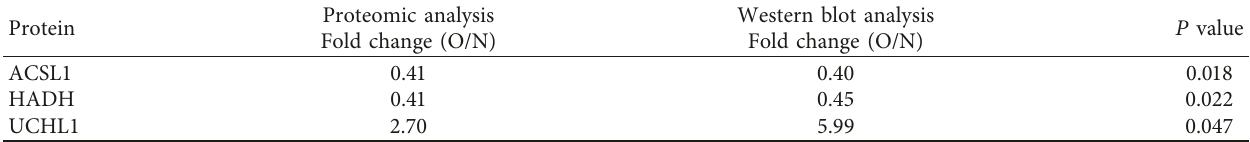
Table 4: Protein expression by proteomic and western blotting analysis.